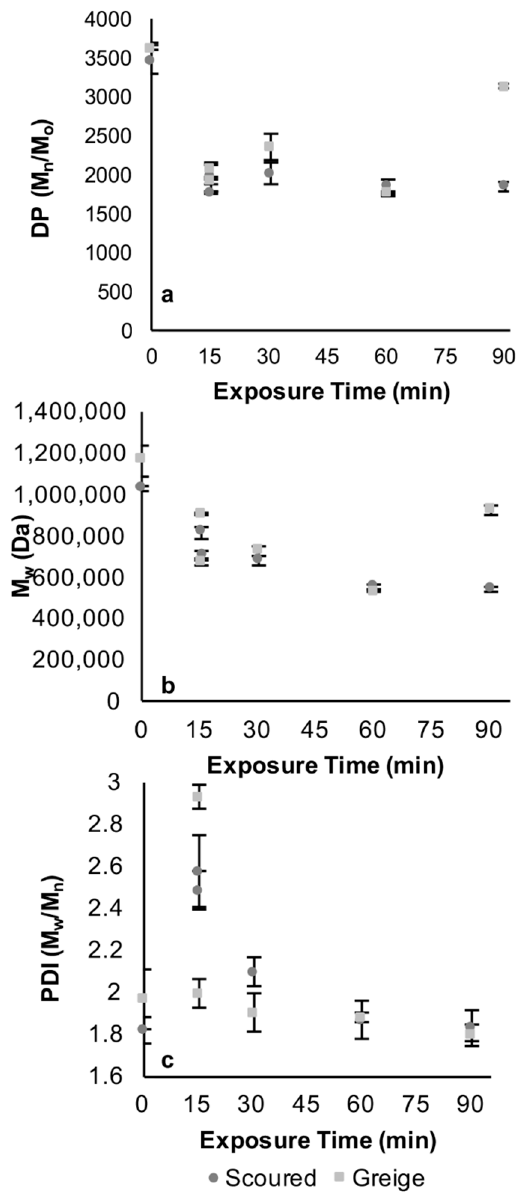
Figure 4. At 0.46 W/cm 2 power density, the effect of plasma exposure duration on the ( a ) degree of polymerization (DP); ( b ) weight-average molecular weight, and ( c ) polydispersity, as determined by GPC, Bars = standard deviations. M w = molecular weight. PDI = polydispersity index.